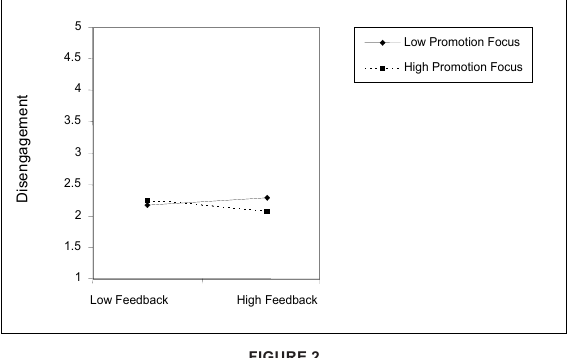
FIGURE 2 Promotion focus moderating the relationship between feedback and disengagement in sample 1